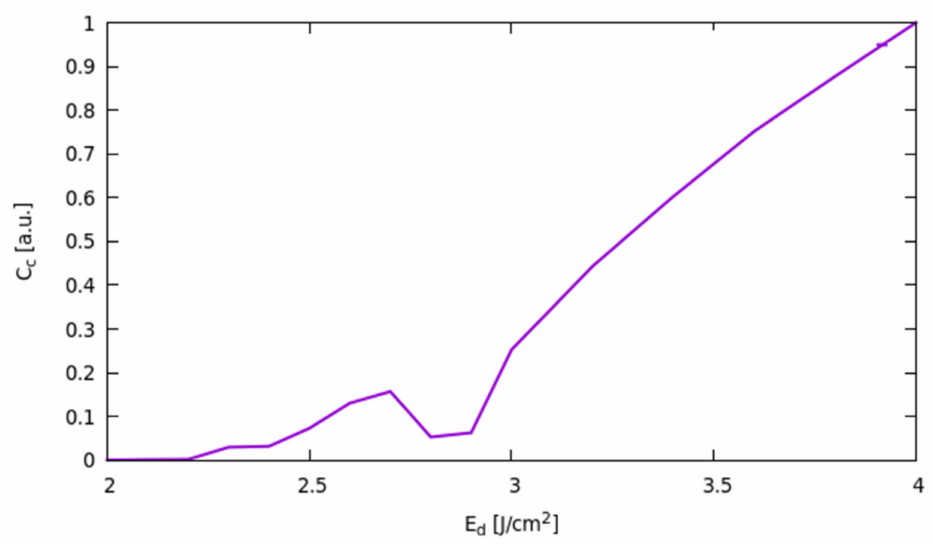
Figure 11. Carbon cluster density ratio as a function of the fluence of the E dens